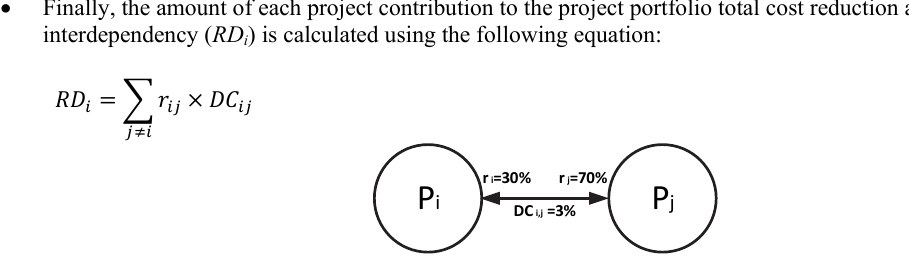
Fig. 1. Graphical view of projects interactions caused by the shared resources